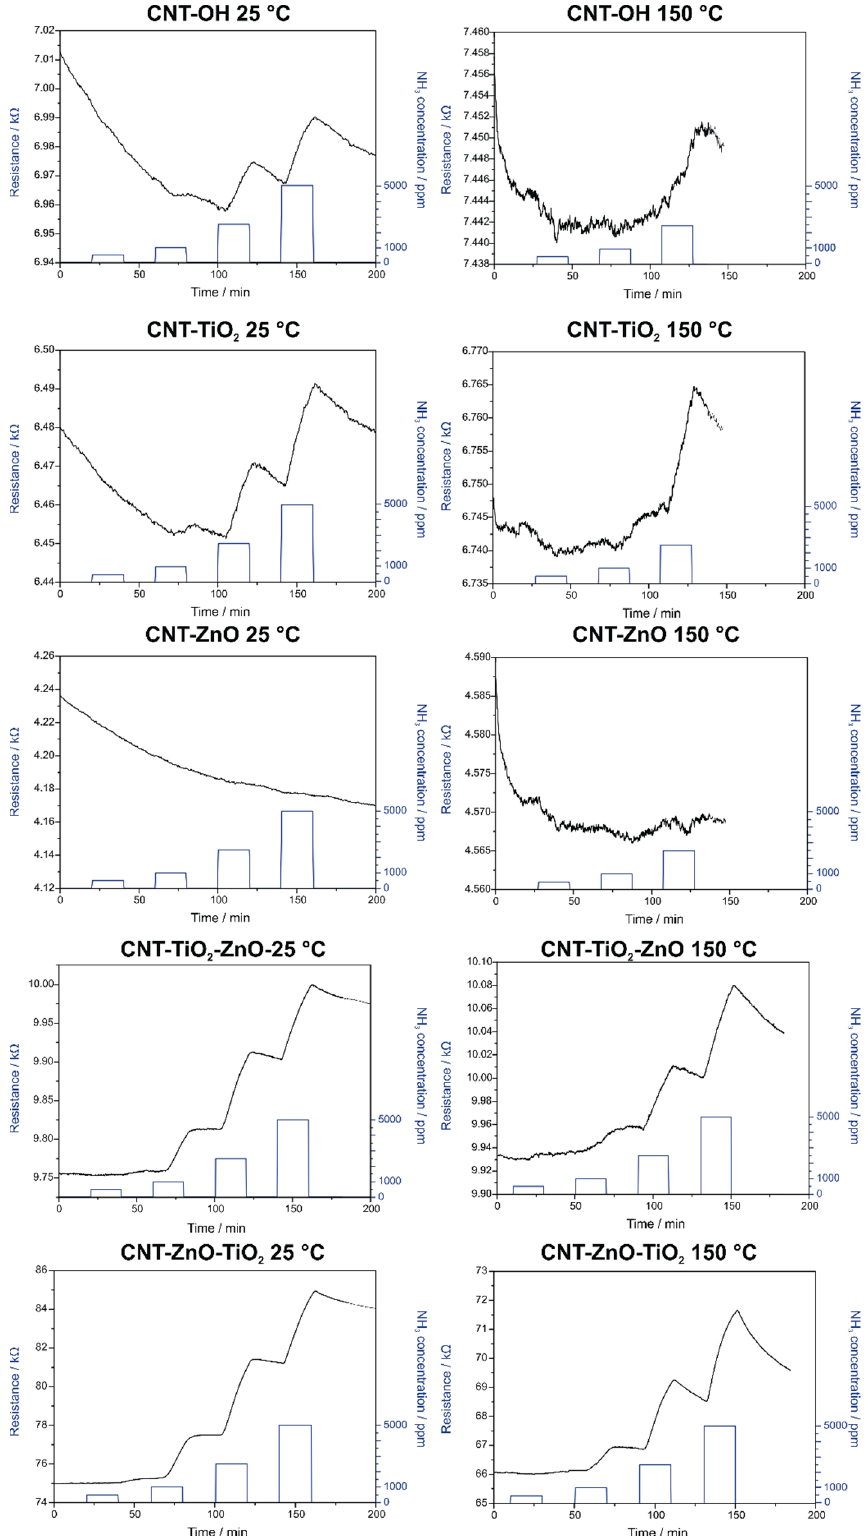
Figure 8. NH 3 gas sensing measurements of the various samples.